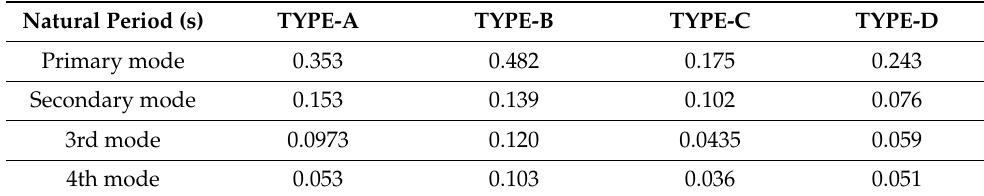
Figure 35. Classification of gravity dams when viewed in terms of the amount of existing reinforcing bars and slenderness ratio of dams near the area where the four dams exist. Table 5. Natural period of each dam.